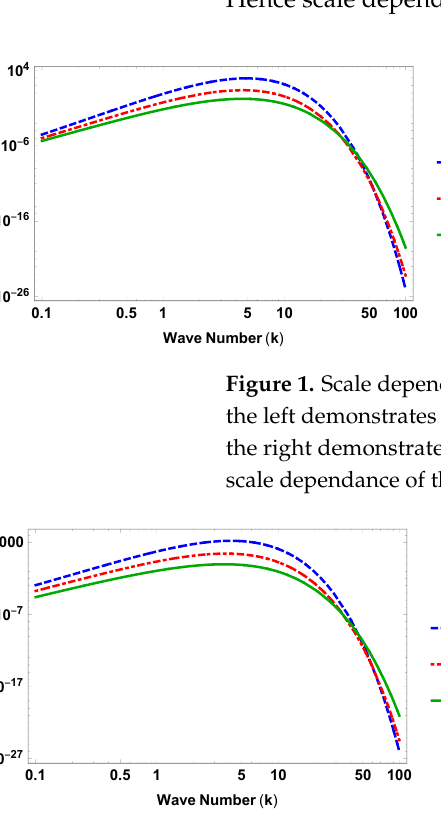
Figure 2. The above figures demonstrate scale dependance of electric power spectrum. The figure on the left demonstrates the normalized electric power spectrum for negative choices of ν , while that on the right demonstrates the same for positive values ν . Alike the magnetic power spectrum, these figures also depict a very similar scale dependant nature of electric power